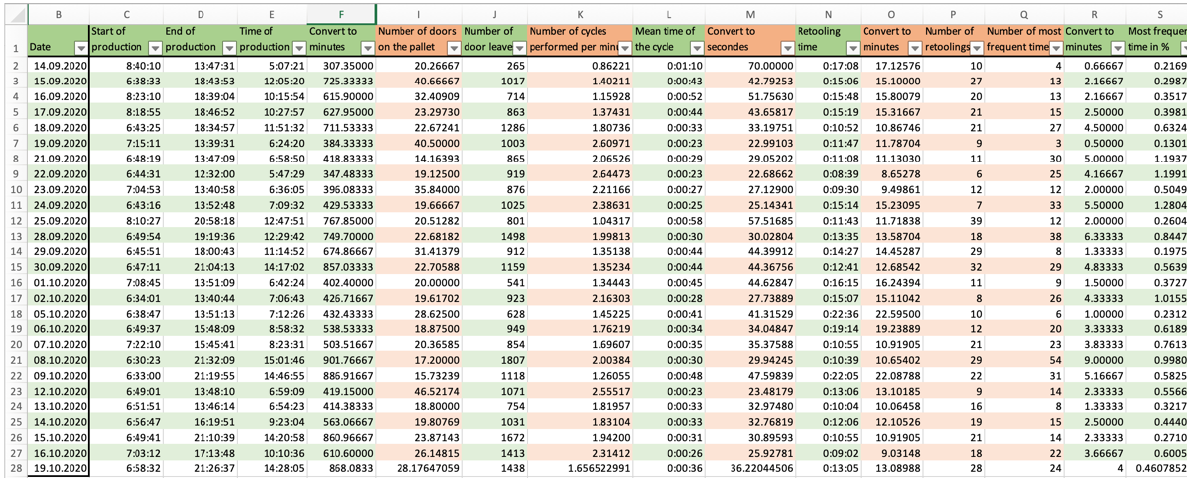
Figure 5. An example of the statistical parameters determined based on the machine data.